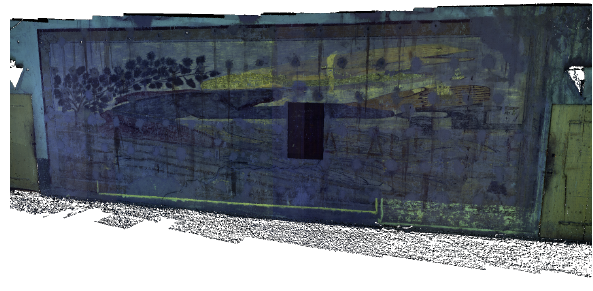
Figure 2: Results of the multiband data acquisition and process- ing (VIS/IR/UVF) on Anamorphosis